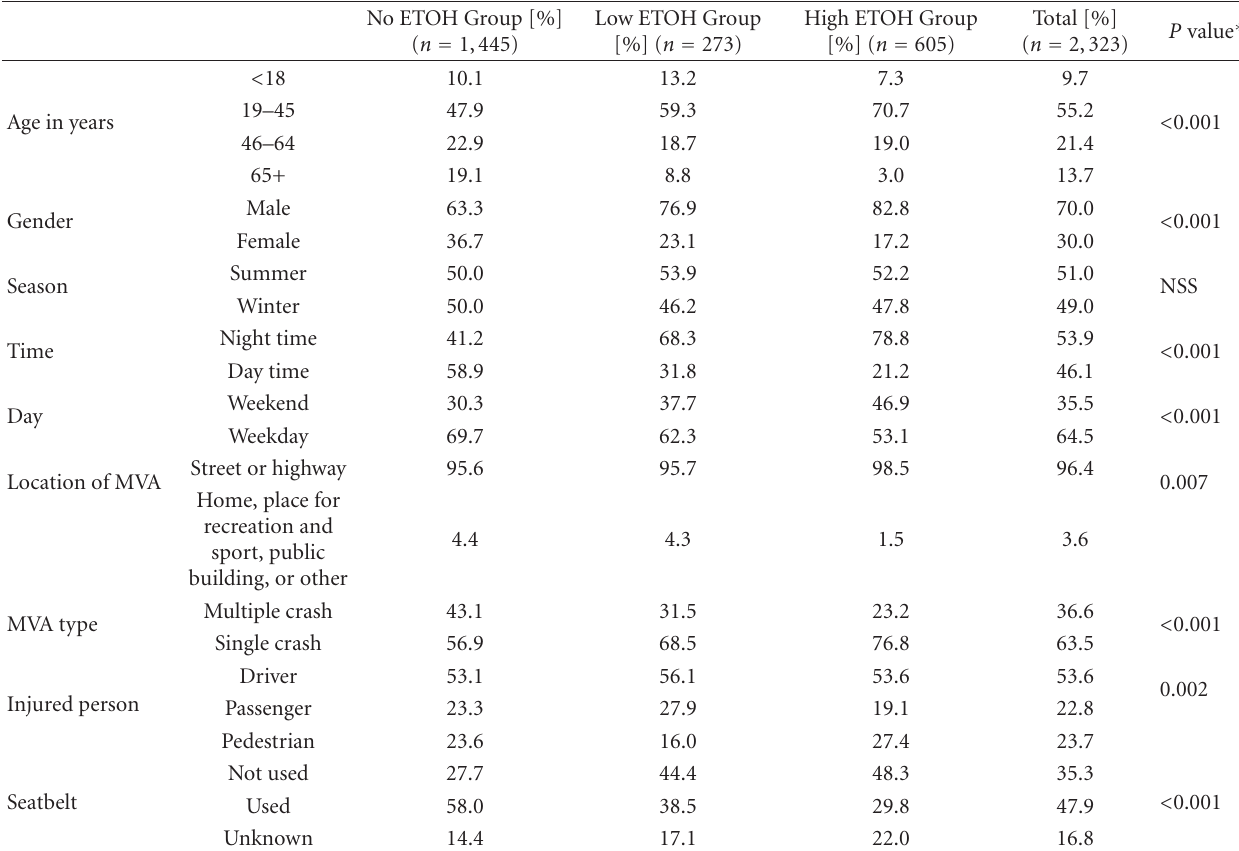
Table 1: Characteristics of patients and MVC.